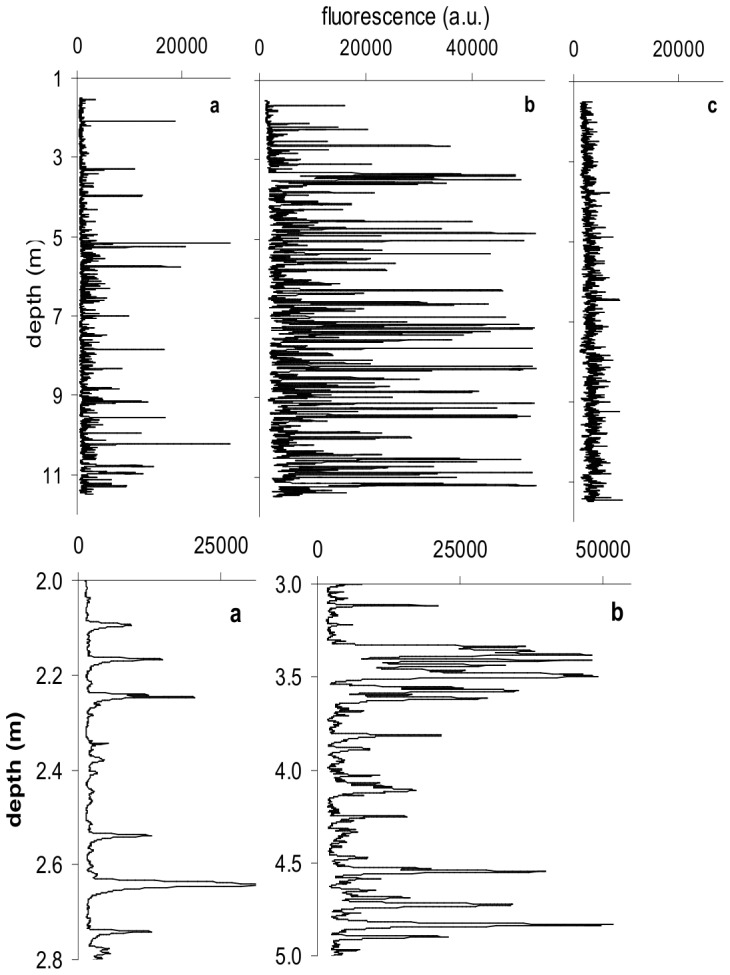
Three representative examples of 90 profiles of chlorophyll fluorescence taken over 3 months in the eastern English Channel.They are from 23/3/04 (a), 26/5/04 (b) and 20/6/04 (c). Fluorescence measurements are in relative arbitrary units (a.u.). Expanded sections of b, showing the regularity of peak spacing (d) and the variety of peak width and height (e). The baseline is 25 times below the highest peak. Noise levels were under 200 a.u.